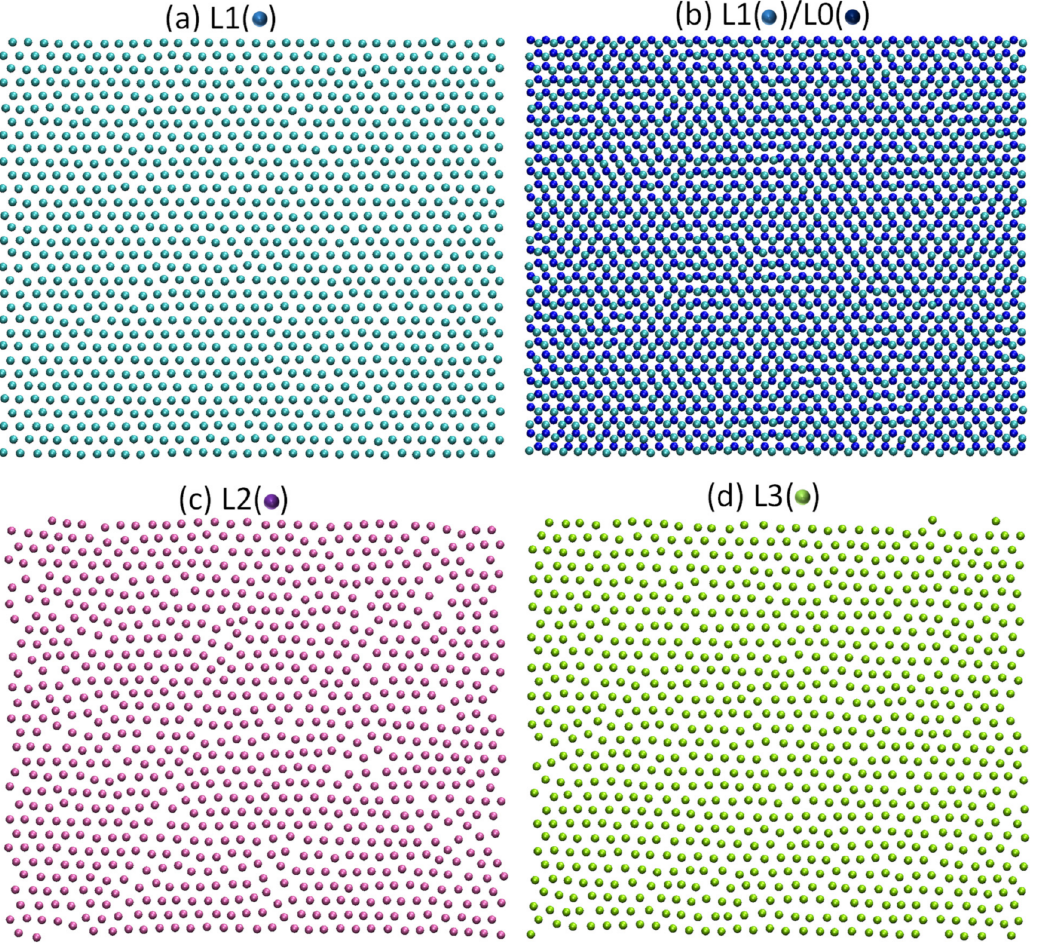
Figure 11. Heterogeneous nucleation mechanism in systems with positive misfit [38]. For the system with 8% misfit, nucleation occurred at T n = 739 K and finished at t = 50 ps. ( a ) A snapshot of L1 and ( b ) a snapshot of L1 on top of L0 (the substrate) showing epitaxy relationship between L1 and L0; ( c ) a snapshot of L2 showing the existence of vacancies in L2; and ( d ) a snapshot of L3 showing the 2D nucleus which is a plane of the